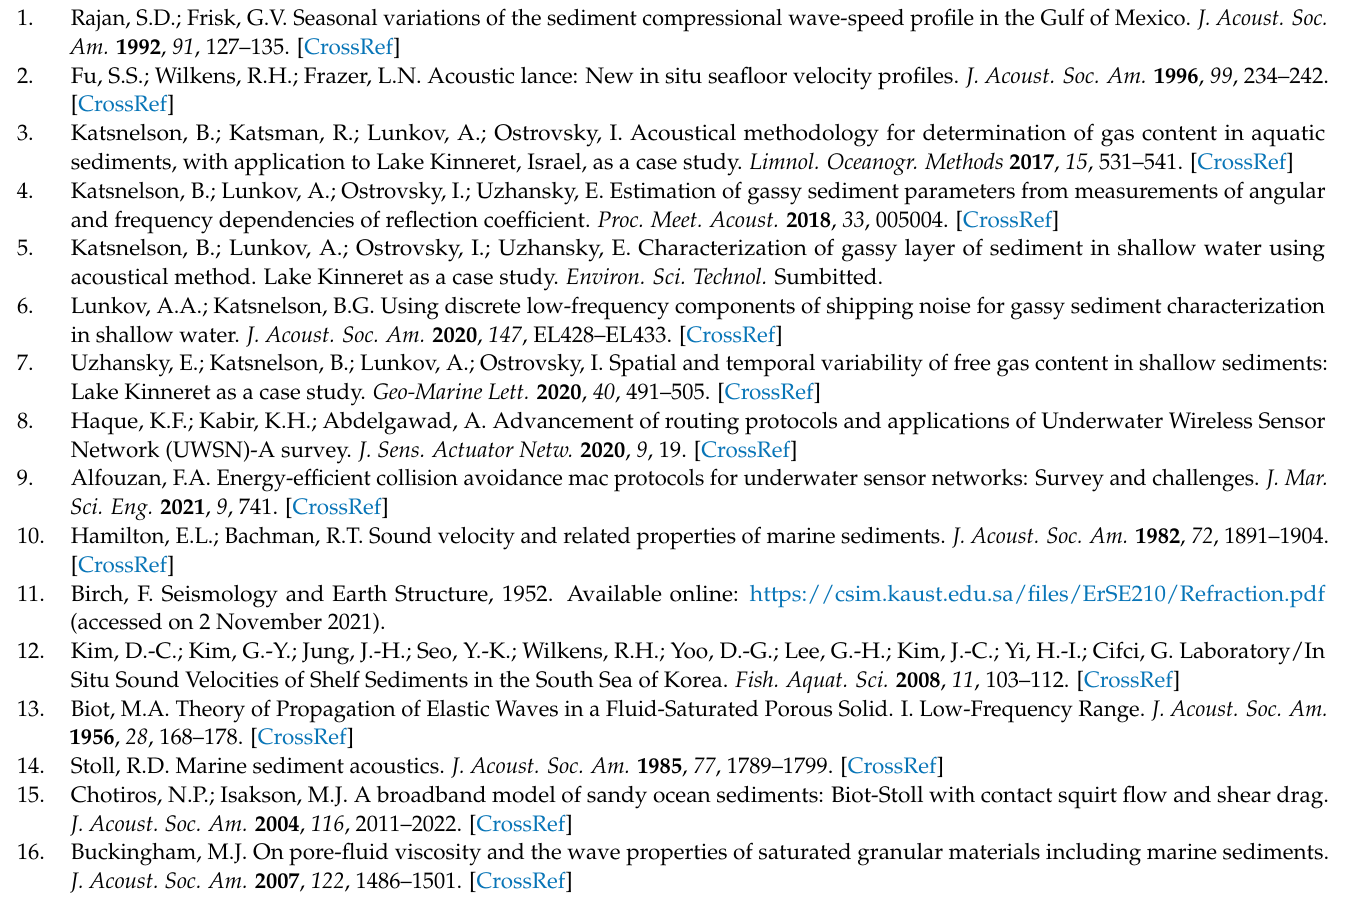
Figure S2: The distribu-tion of the interval velocities vs the depts at the middle of each interval, estimated through mi-gration analysis of the seismic line